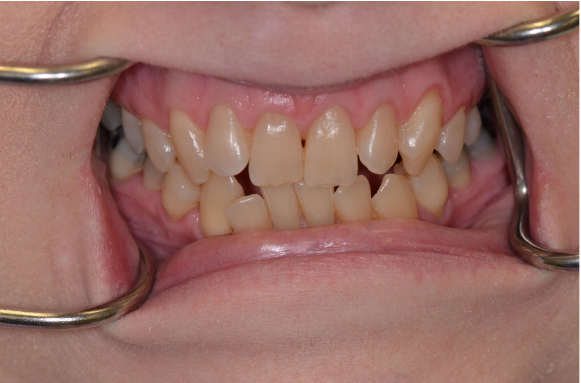
Figure 1. A 62-year-old female has moved to the region recently and seeks treatment. Apart from hypertension, which she controls through diet, medication (thiazide diuretic), and exercise, she has no other systemic diseases. She has all of her dentition, except for the third molar. There is some anterior crowding in the mandible, with minimal bone loss. She has no other important risk factors, and her daily oral hygiene is excellent. This patient represents a person who has no important risk factors, and therefore rapid oral health deterioration is not occurring.